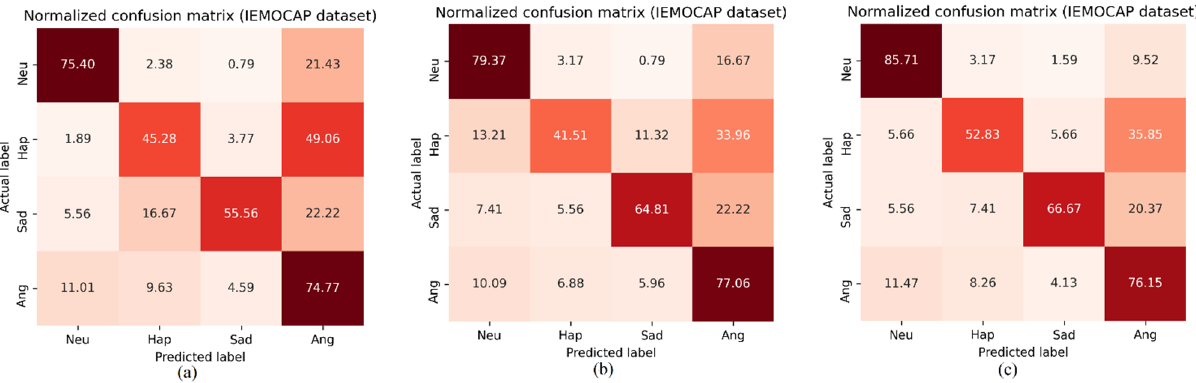
Figure 4. The confusion matrix on the IEMOCAP dataset. ( a ) The Conv-Cap module with a UA of 62.75%, ( b ) the Bi-GRU module with a UA of 65.68%, and ( c ) the proposed model with a UA of 70.34%.